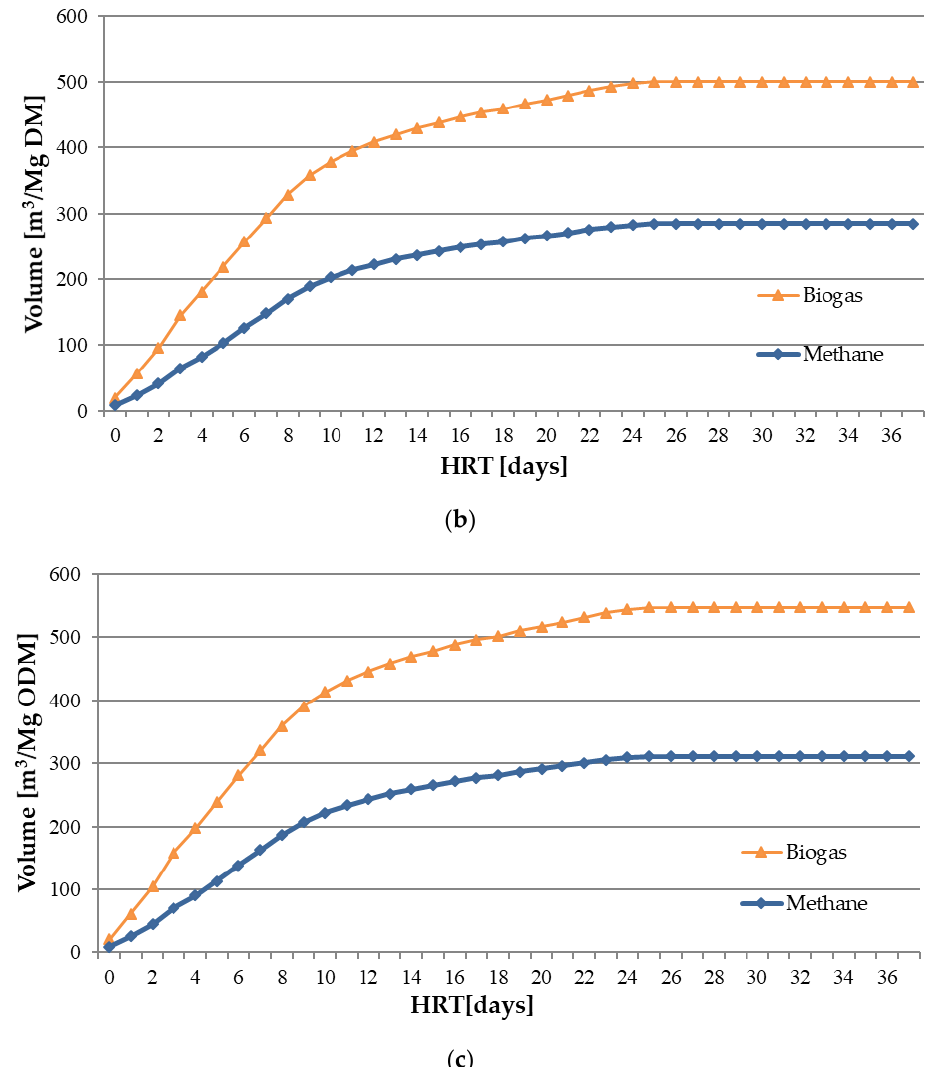
Figure 3. Graph of the accumulated production of biogas and biomethane as a function of time converted into: ( a ) fresh mass of silage (FM), ( b ) dry matter (DM), and ( c ) organic dry matter (ODM).